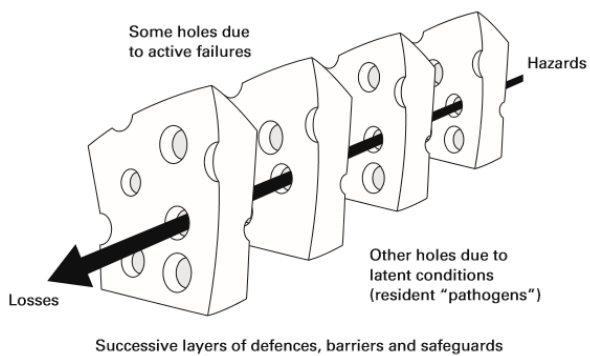
Figure 1. “Swiss Cheese” risk model of James Reason [7]. Source: Reason, J.T.; Carthey, J.; Leval, M.R. Diagnosing “vulnerable system syndrome”: An essential prerequisite to effective risk management. Qual. Health Care 2001 , 10 , ii21–ii25.